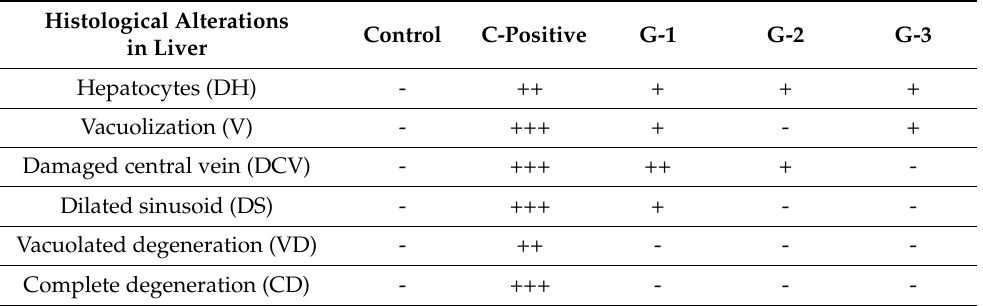
Table 5. Comparison of various histological abnormalities in the livers of common carp from control and treated groups. Please note that five fields of one histological section per sample were analyzed.